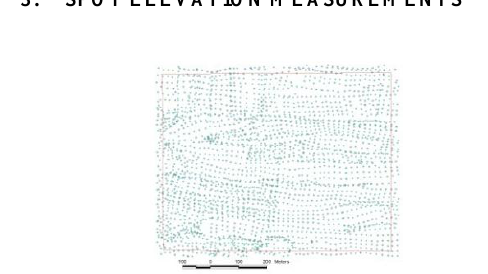
Figure 1: Spot elevation